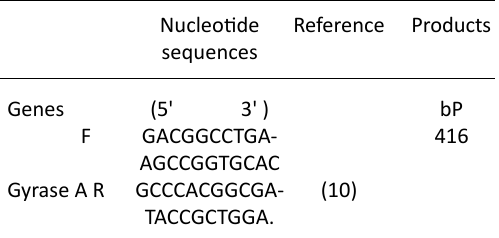
table 1 . Sequences of primer that use to detection II topoisomerase (GyrA gene).